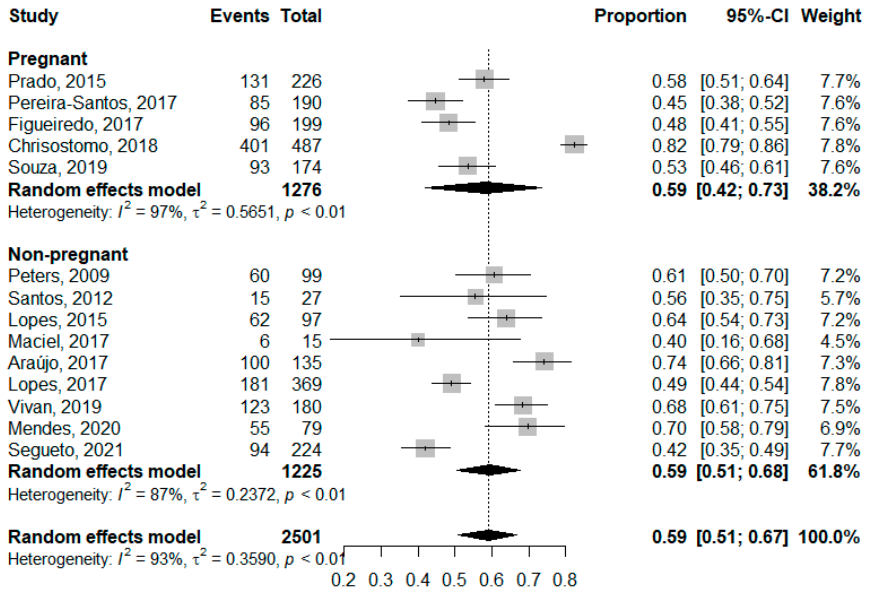
Figure 4. Prevalence of Vitamin D insufficiency in childbearing women stratified by pregnancy status.